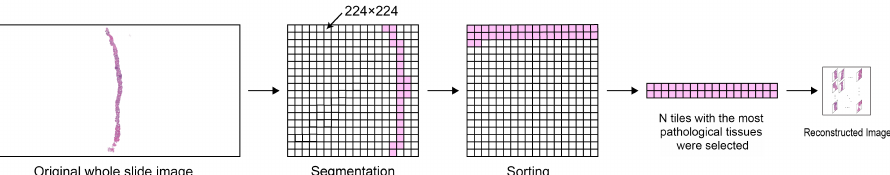
Figure 1. An overview of our data preprocessing method. Firstly, we apply image augmentation to the original whole-slide images to enhance the dataset diversity. We further slice each image into smaller tiles in 224 × 224, followed by a sorting of these tiles based on the mean pixel value. The top N (N = 36 in this study) most informative ones are selected to form a new image, which is a 6 × 6-tile square